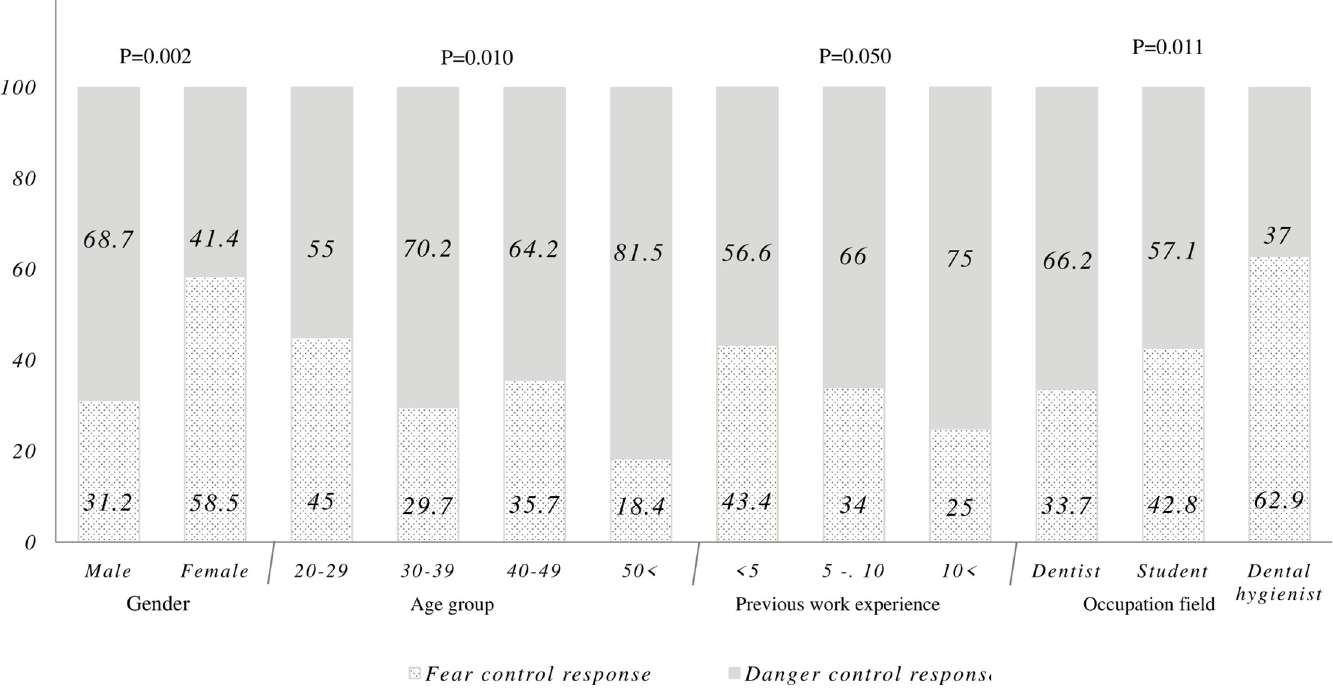
Fig 3. Results of the discriminating value formula for danger control